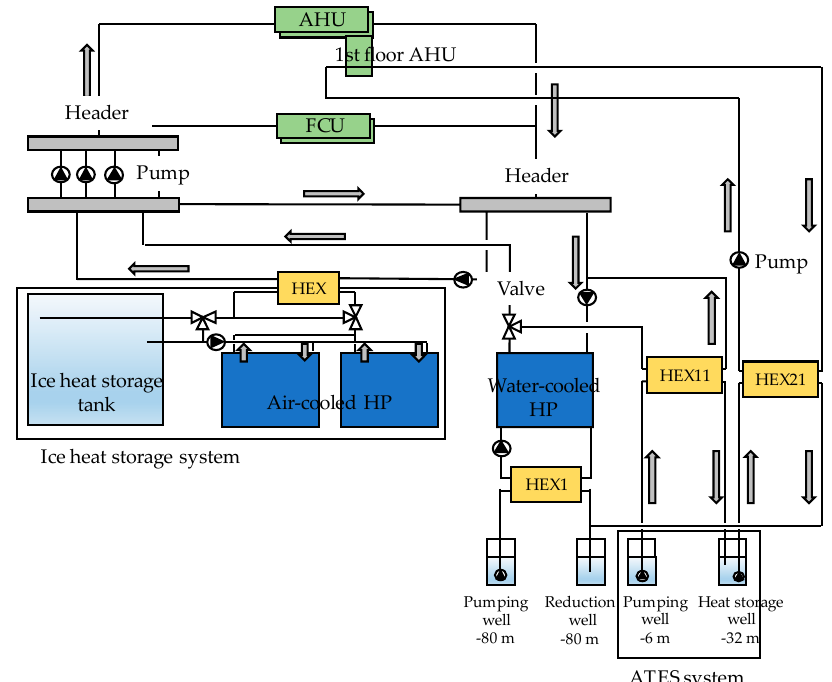
Figure A2. System diagram of the target air conditioning system.